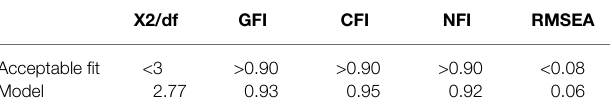
TABLE 5 | Goodness of fit